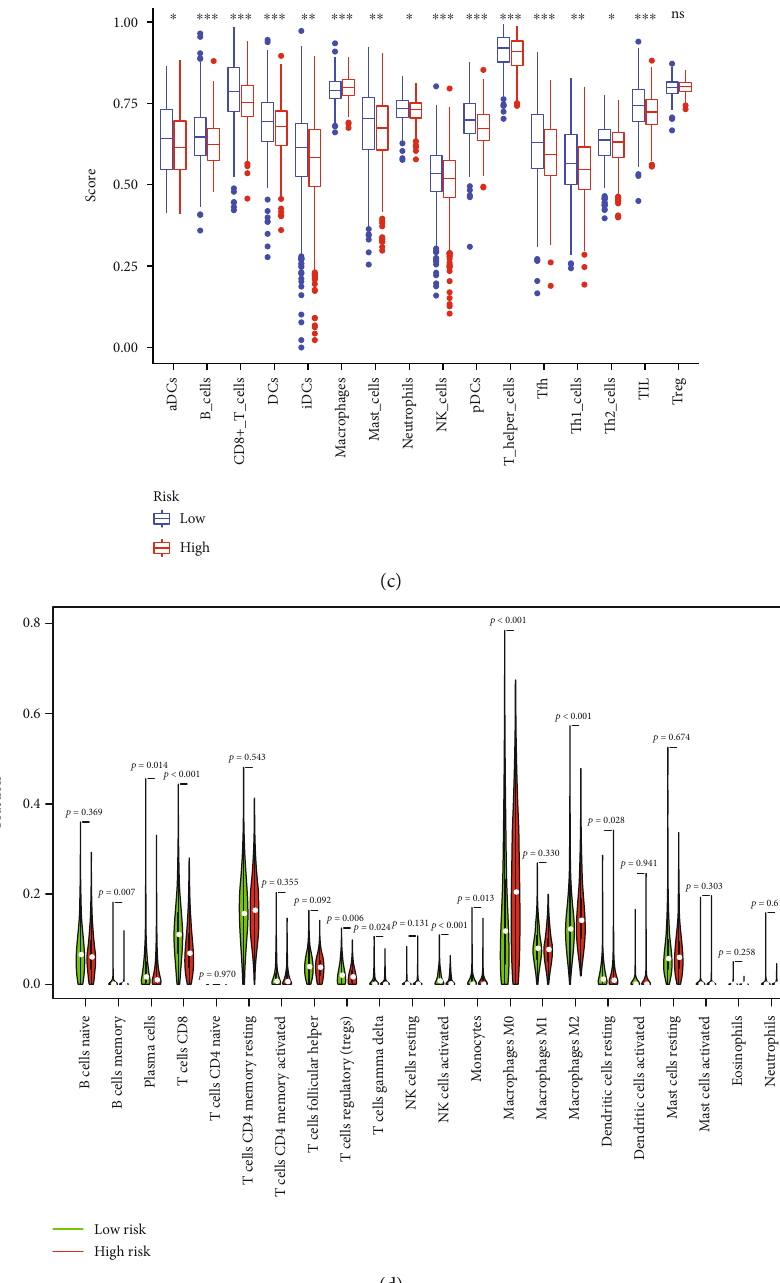
Figure 9: Immune-in fi ltrating cell score analysis of tumor microenvironment in patients with di ff erent risks. (a) The proportion of immune-in fi ltrating cells in tumors. (b) Heat map of tumor immune-in fi ltrating cell expression. (c, d) Showing levels of in fi ltration of immune